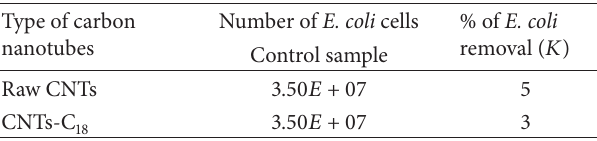
Table 1: The percentage of E. coli removal under the effect of CNTs and CNTs-C 18 .